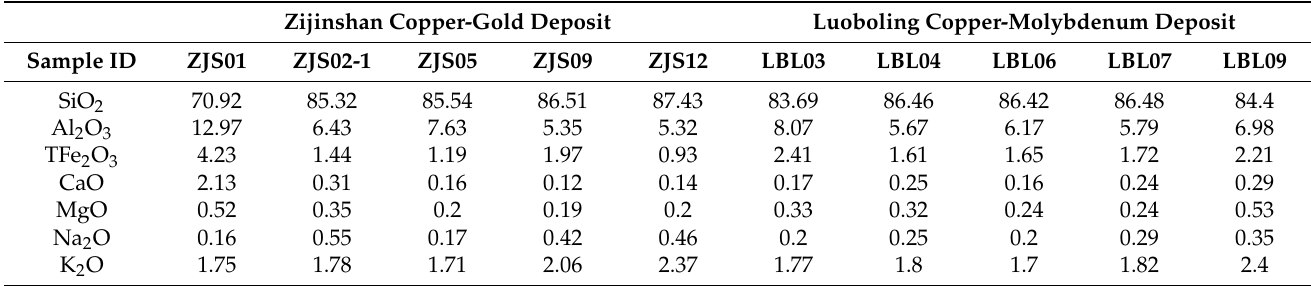
Table 1. Element compositions 1 of stream sediments in the Zijinshan Copper-Gold